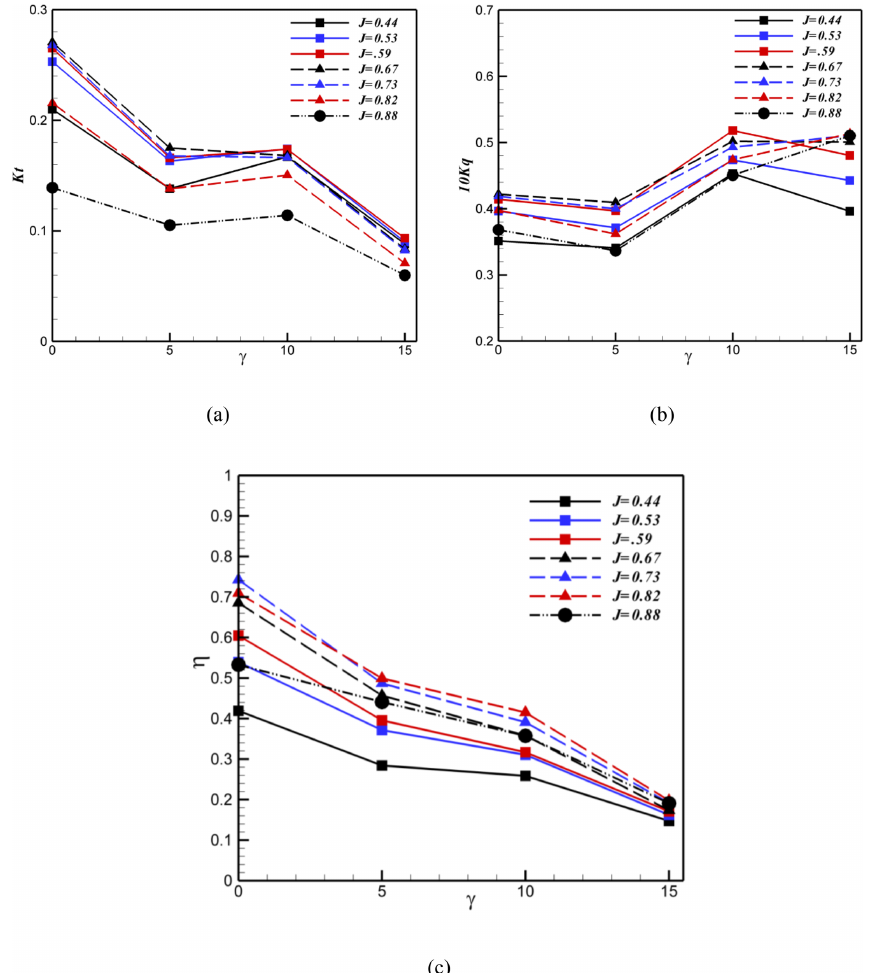
Figure 15. Effect of shaft inclination angle on the hydrodynamic coefficients and efficiency of the surface-piercing propeller at different advance coefficients and 40% immersion